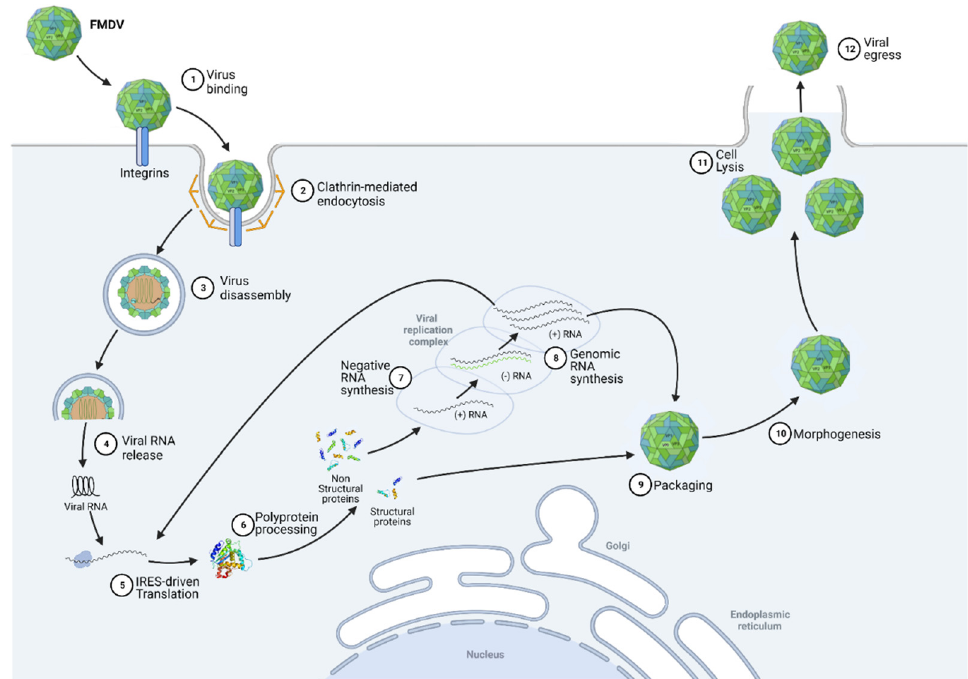
Figure 2. Foot-and-mouth disease virus replication cycle (See text for details). Created with BioRender.com (accessed on 16 August 2022).